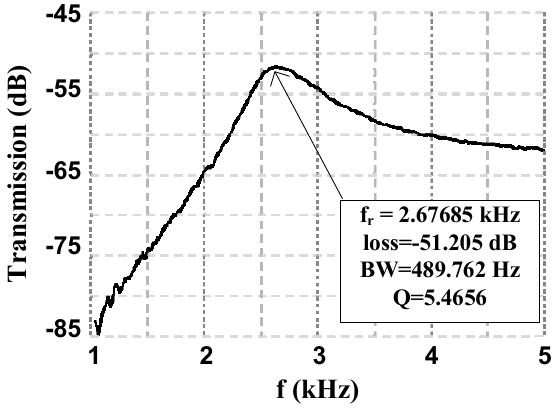
Figure 11. Measured resonance characteristics of the third design at 1 mTorr vacuum level.